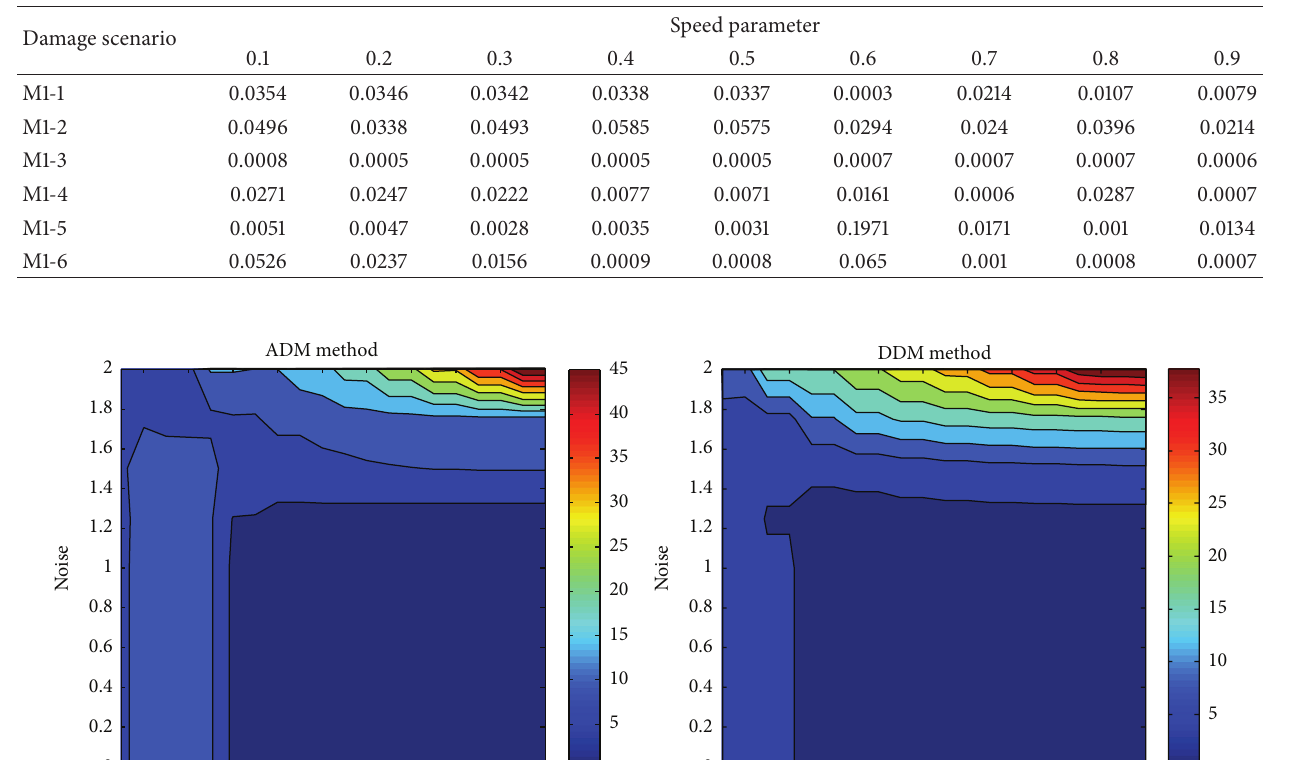
Table 3: RPE of ADM method for model 1.